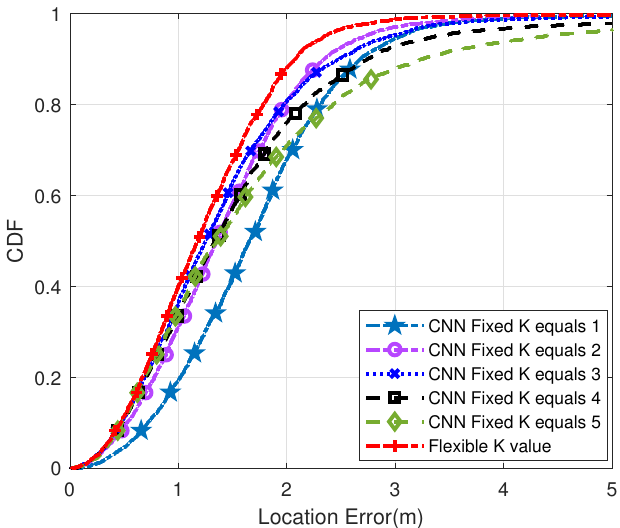
Figure 7. Probability distribution diagram of positioning error when the distance between two reference points is 4 m (Q = 50).